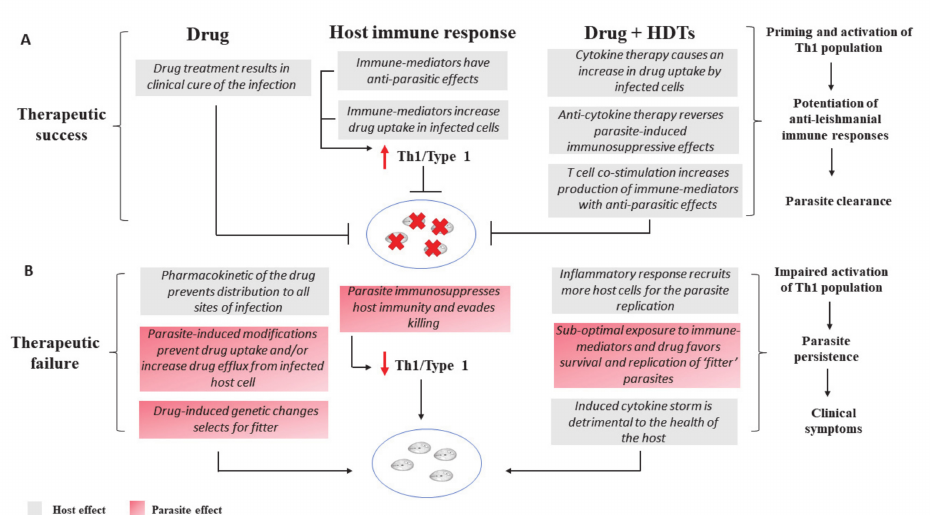
Figure 1. Proposed outcome of management of leishmaniasis using chemoimmunotherapeutic approach. ( A ): Therapeutic success can be achieved via three possible routes. Administration